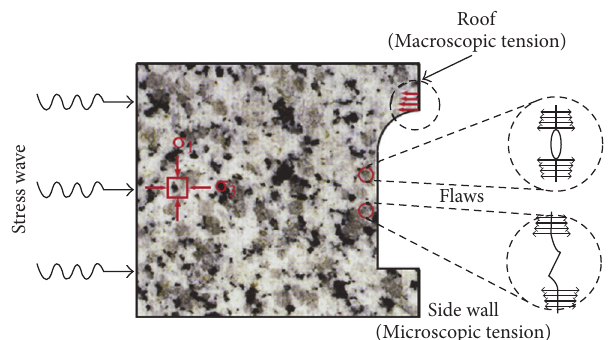
Figure 1: Potential sources of tensile failure around an underground opening [8].